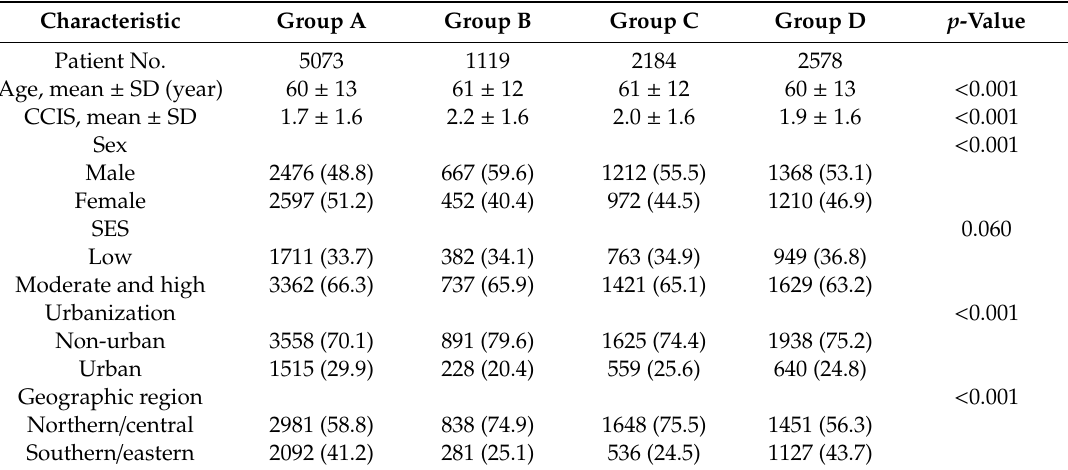
Table 1. Baseline characteristics *.